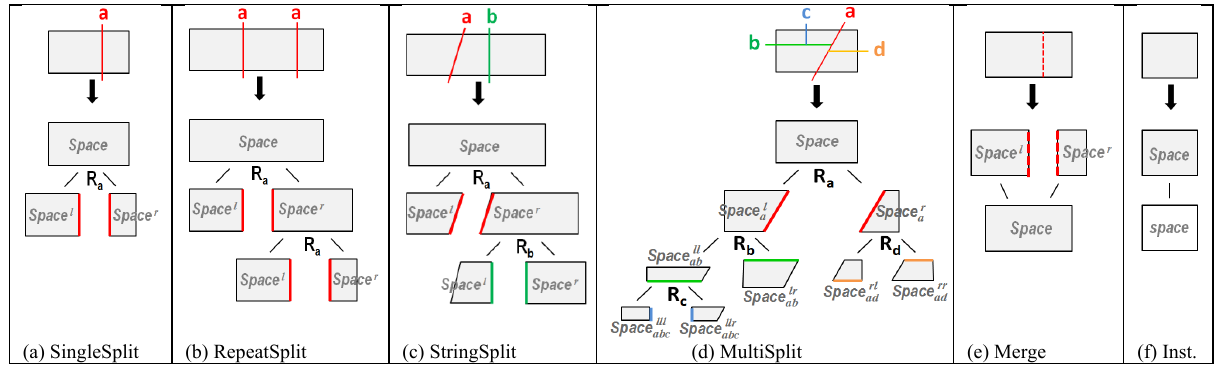
Figure 1. Split grammar: different rule types and their geometric